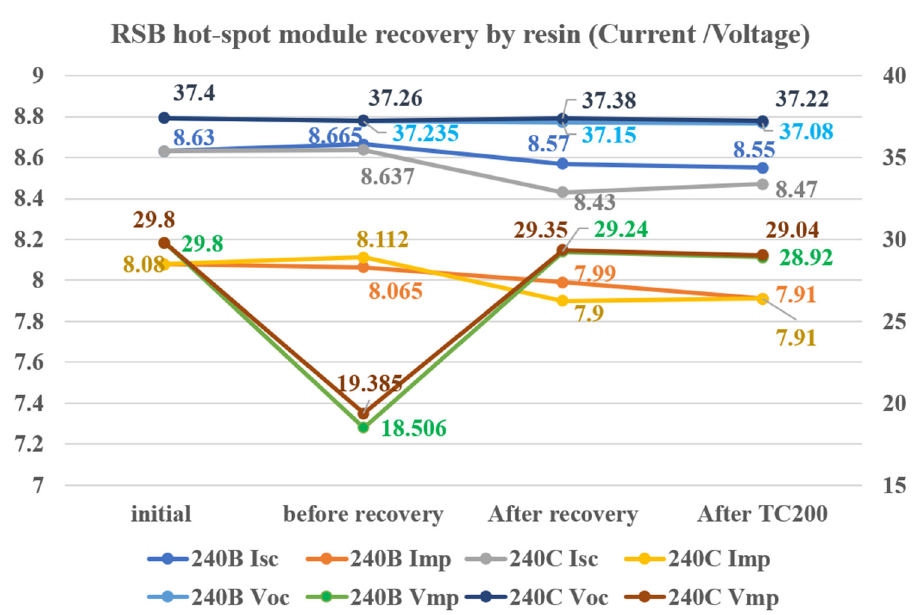
Figure 17. Result of RSB hotspot module recovery by resin. (I sc , I mp , V oc, and V mp ).